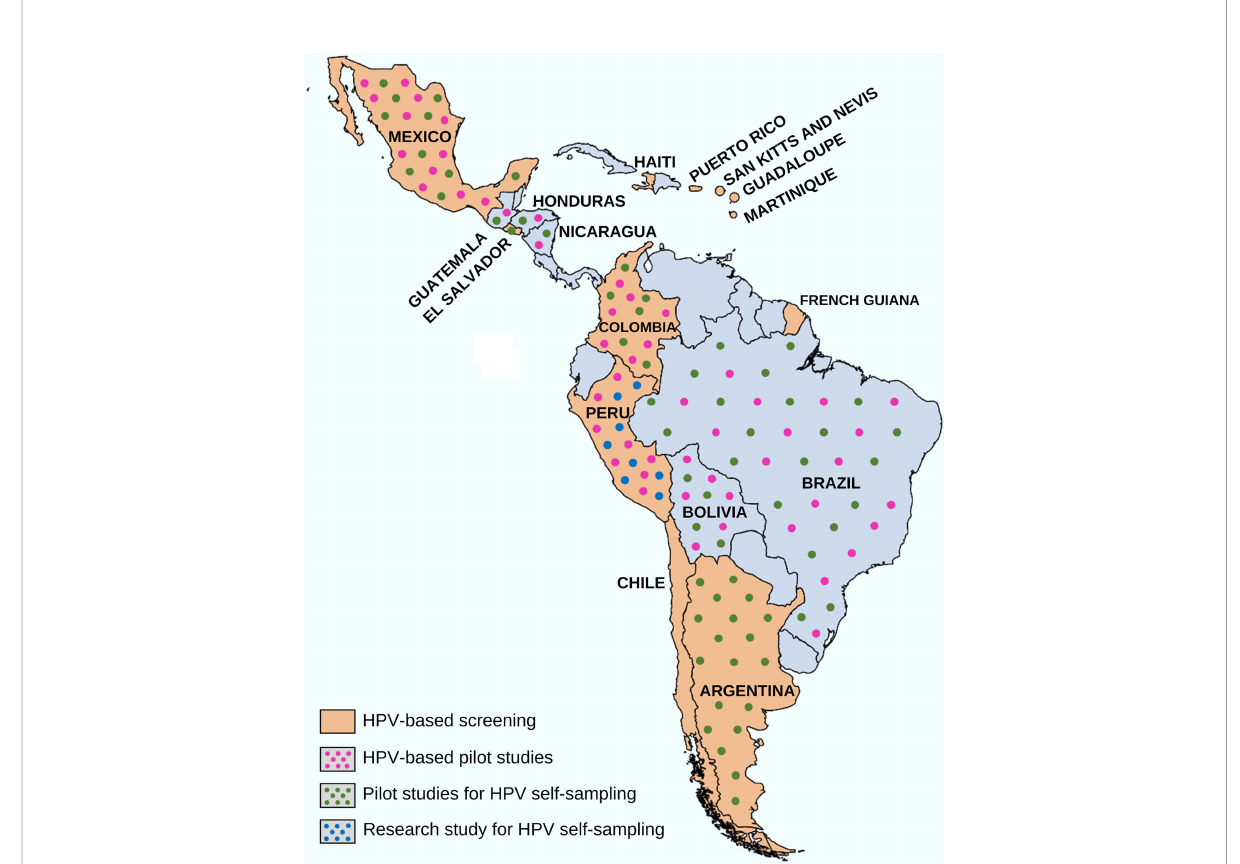
FIGURE 2 Recent HPV self-sampling approach in Latin America and Caribbean countries and